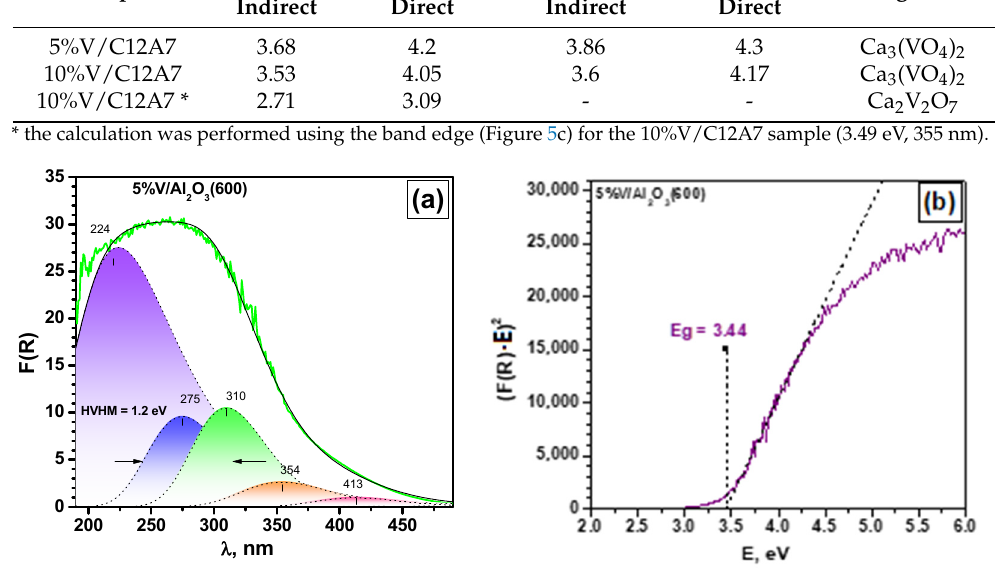
Figure 6. Diffuse reflectance UV–Vis spectrum of 5%V/Al 2 O 3 reference sample calcined at 600 °C with the bands after deconvolution in accordance with [63] ( a ). Dependence of ( F ( R ) · E ) 2 on E characterizing the energy gap width (direct allowed transition) E g ( b ).